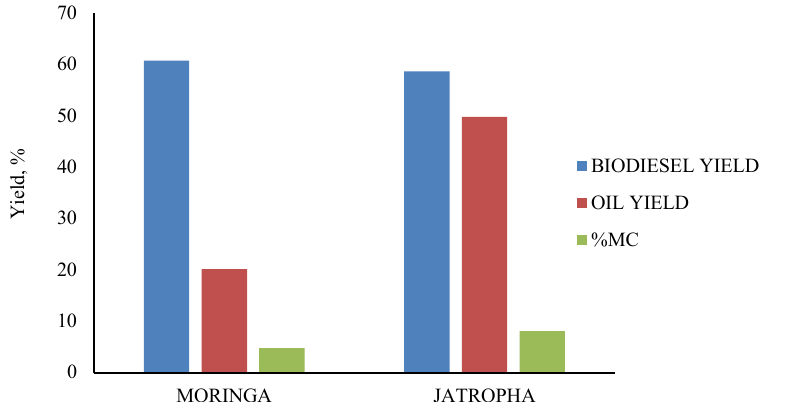
Fig. 3. Relationship between moisture content, oil yield and biodiesel